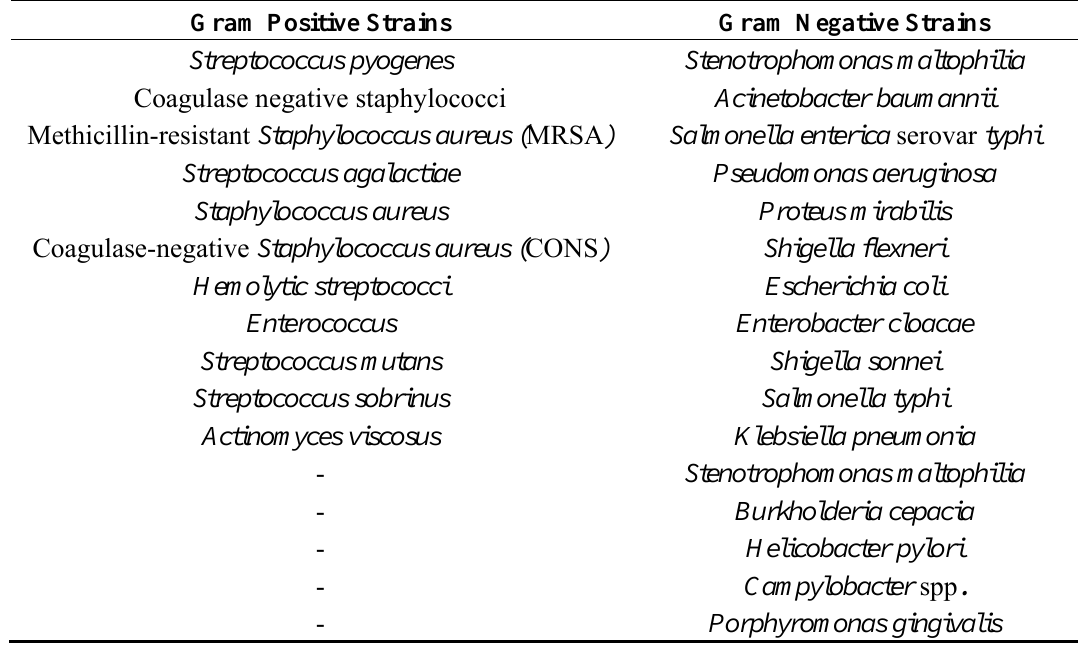
Table 2. List of microorganisms that have been found to be sensitive to manuka honeys